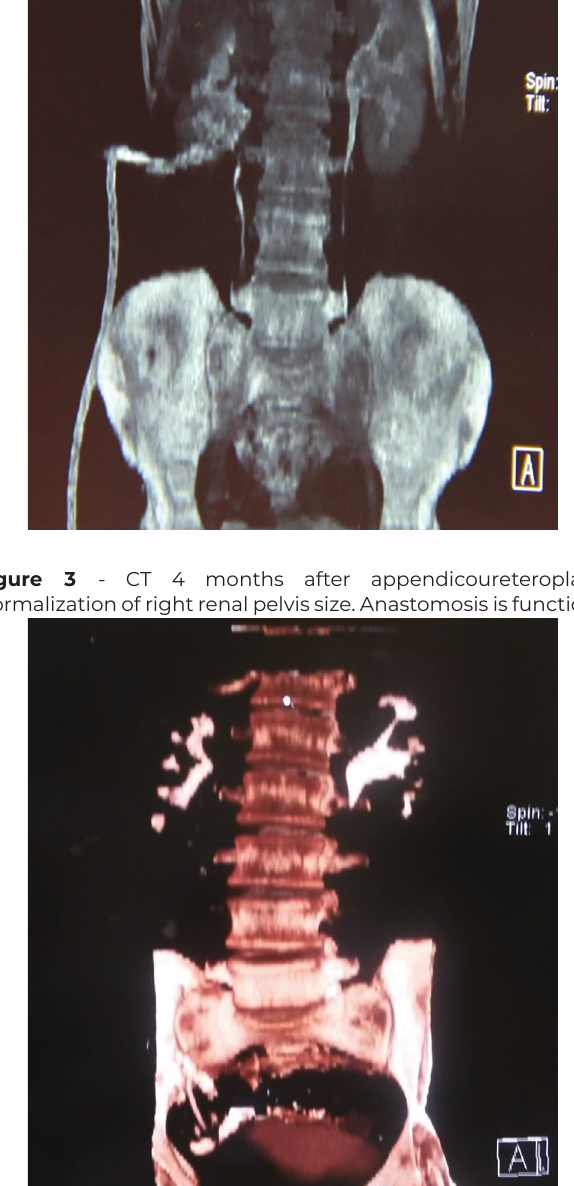
Surgical interventions Appendicoureteroplasty